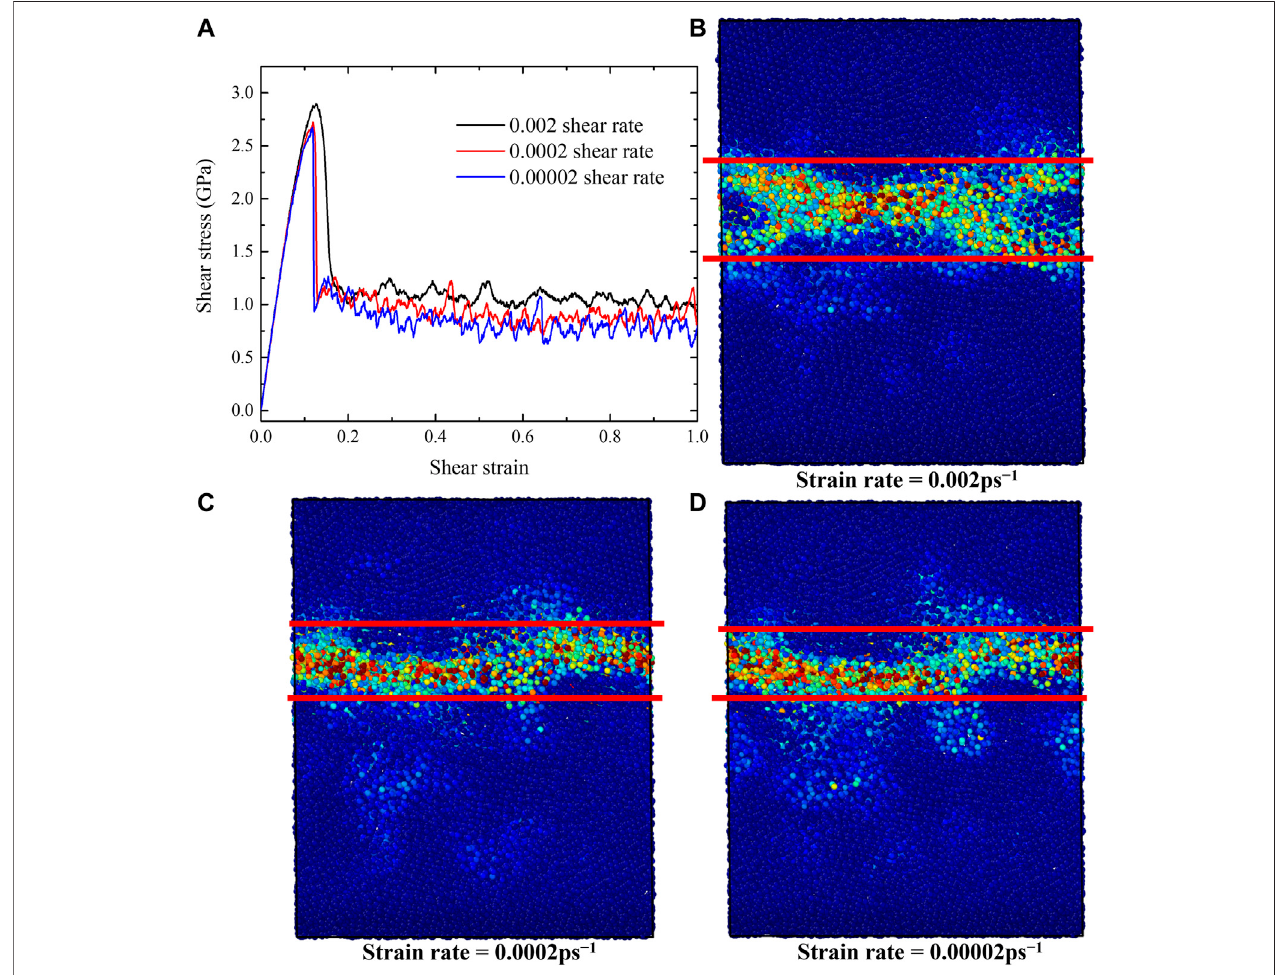
FIGURE 7 | The shear-stress-shear-strain relationships and the atomic von-Mises strain map of G-phase with various strain rates ranging from 0.00002 to 0.002 ps − 1 . (A) The shear-stress-shear-strain relationships, (B – D) the von-Mises strain maps after forming shear band under different strain rates of (B) 0.002 ps − 1 , (C) 0.0002 ps − 1 , and (D) 0.00002 ps − 1